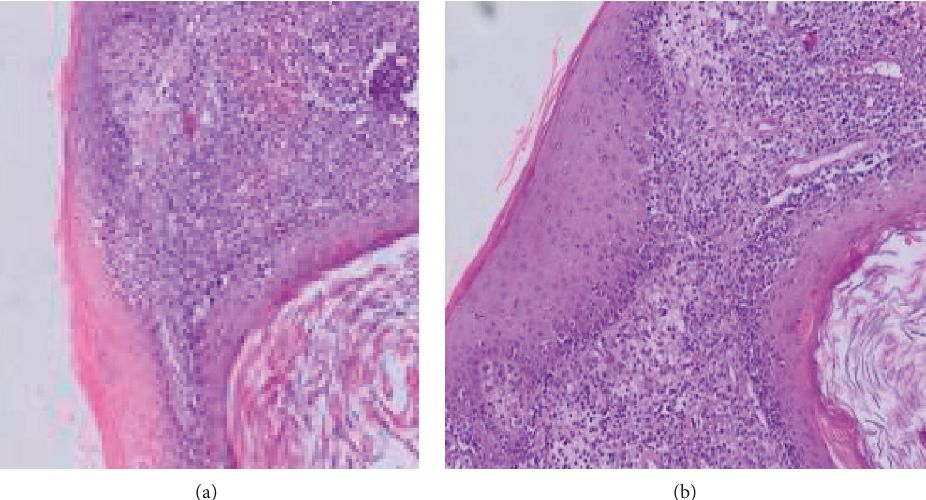
Figure 2: (a) Diffuse lymphoid infiltrate of the dermis and hypodermis epidermotropism, (b) diffuse lymphoid infiltrate of the dermis and hypodermis